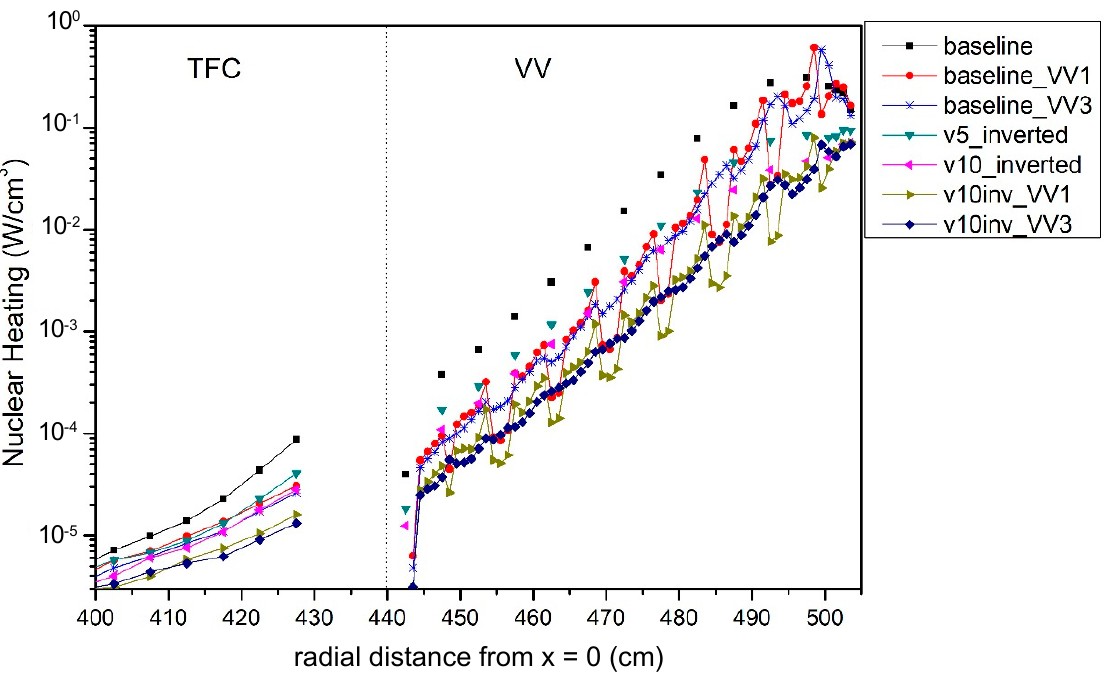
Figure 10. Nuclear heating for the baseline and v10_inverted versions with modified VV. Table 8. Nuclear heating at first radial cm of the TFC for the baseline and v10_inverted versions with modified VV.